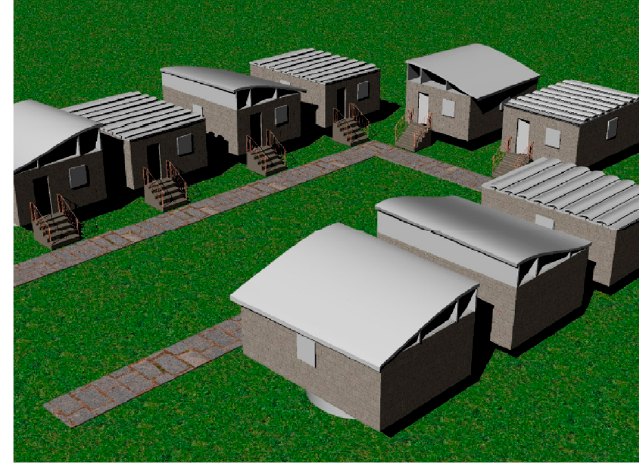
Figure A4. A conceptual housing community made of wind turbine blade waste [46].